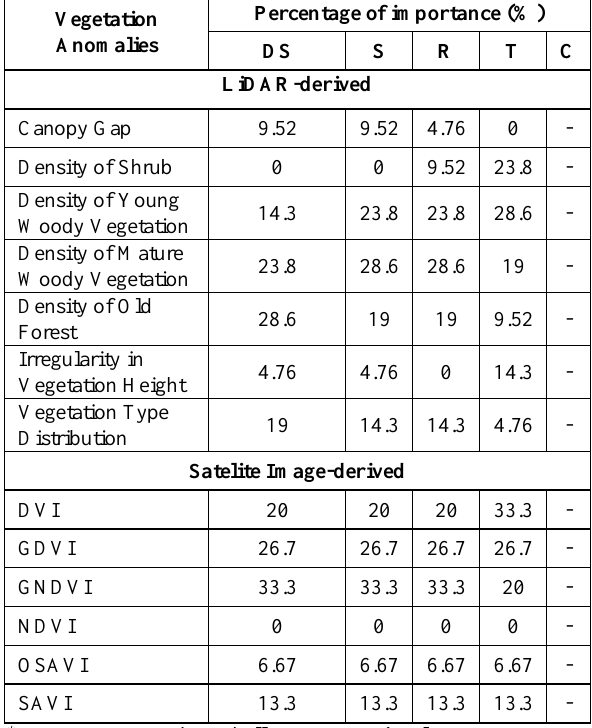
Table 7. Vegetation anomalies index in percentage for dormant landslide activity with different landslide